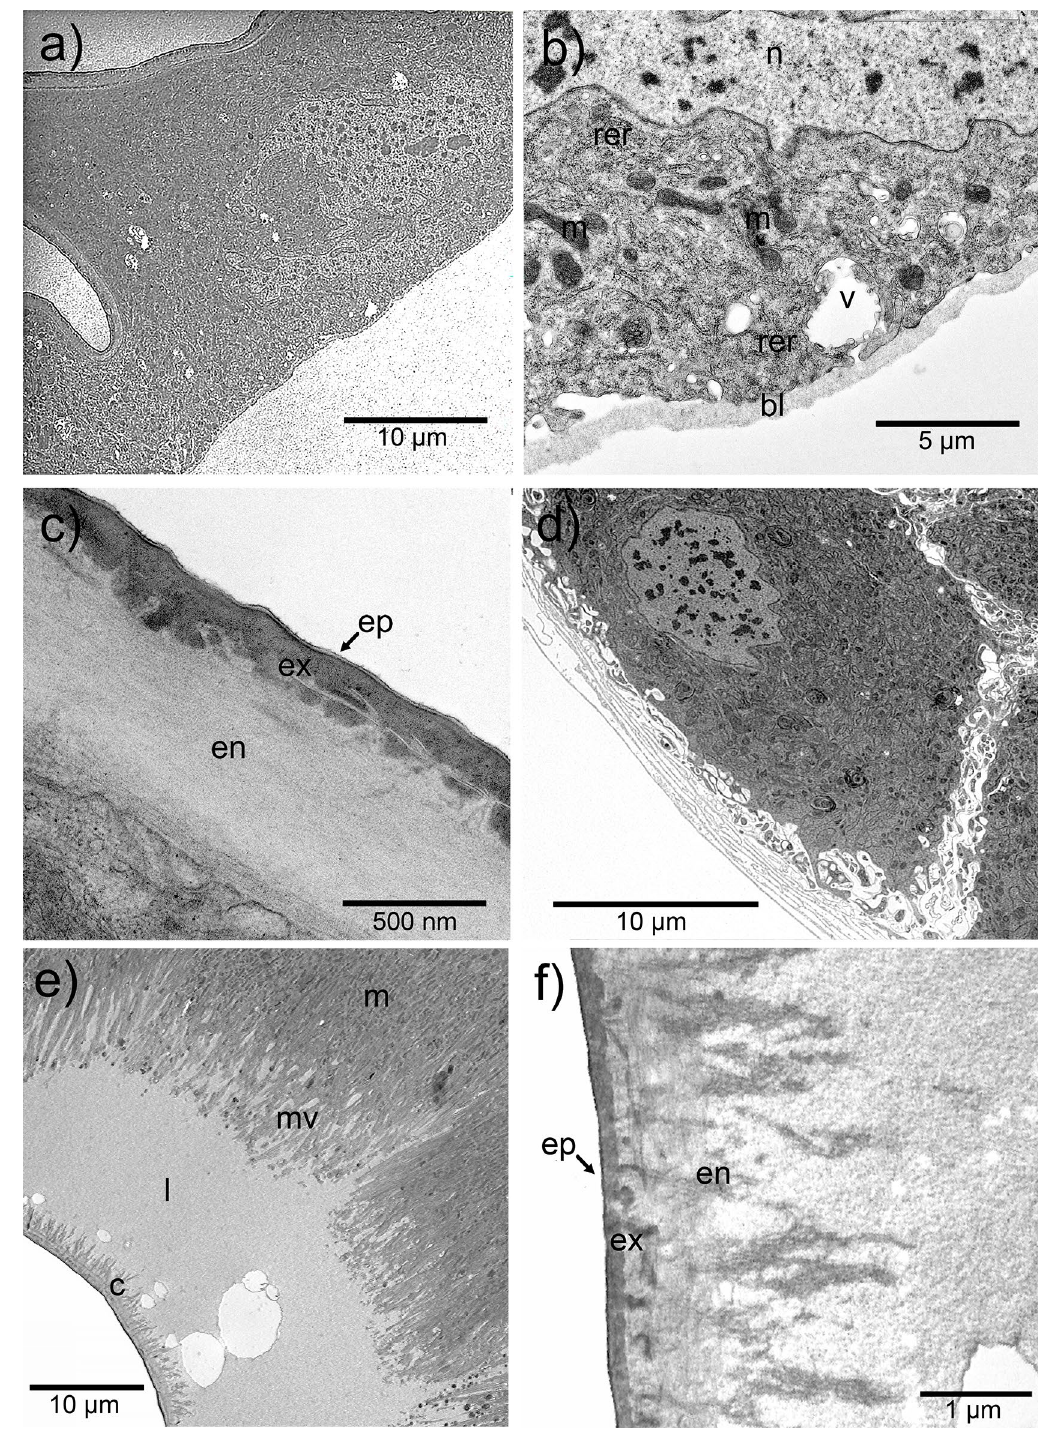
Figure 5. Ultrastructure of cells that compose the osmeterium in Battus polydamas archidamas. ( a ) Overall development of epidermal cells. ( b ) Detail of the cytoplasm of epidermal cell. ( c ) Well-defined cuticle underlying the epidermal cells. ( d ) Overall development of the ellipsoid glands. Note the extracellular channels running up into the cell. ( e ) Apex of the ellipsoid gland cells that shows abundant microvilli and dense secretion-like particles at the lumen of the gland. ( f ) Cuticle at the middle part of the gland pore that shows highly modified endo and exocuticle. Abbreviations: bl, basement lamella; c, cuticle; en, endocuticle; ep, epicuticle; ex, exocuticle; l, lumen; m, mitochondria; mv, microvilli; n, nucleus; rer, rough endoplasmic reticulum; v,